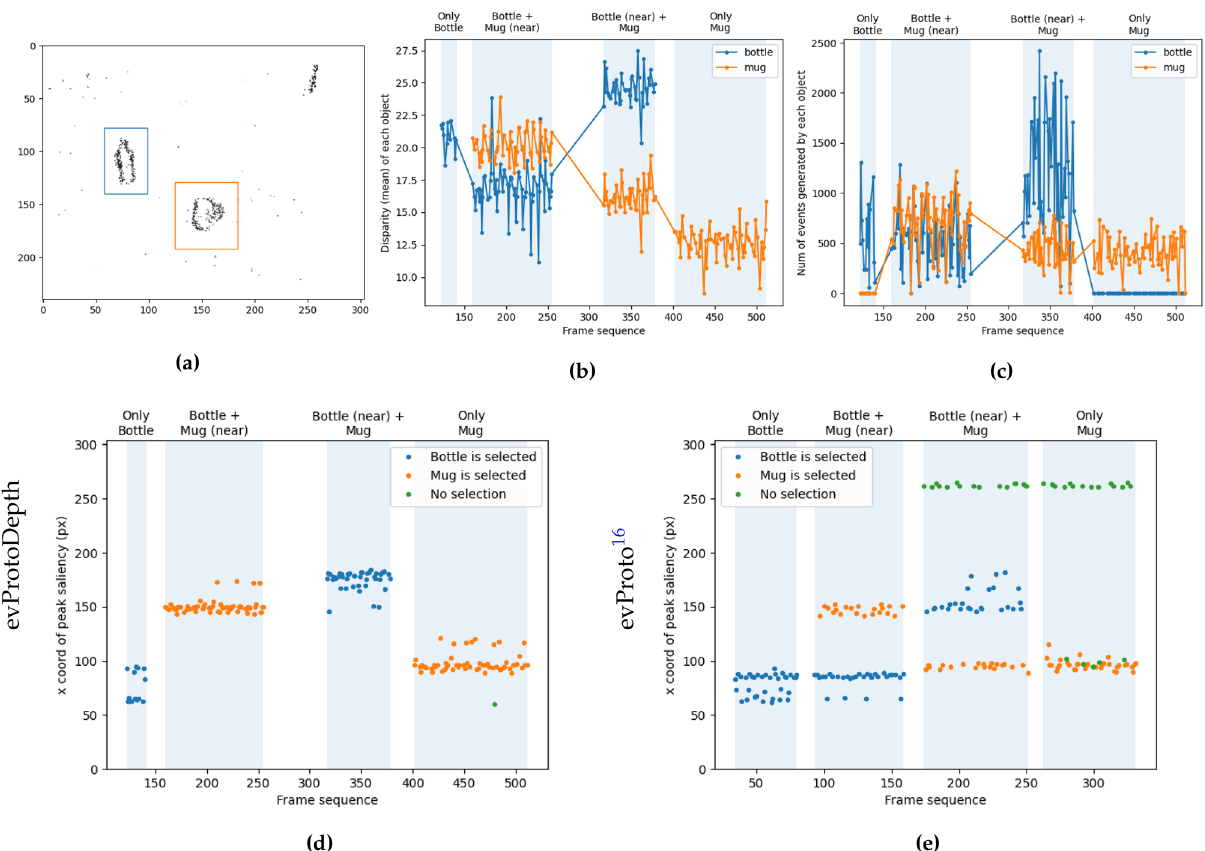
Figure 6. The disparity channel stabilises object selection in the bottle-mug dataset, during which the object positions are moved on a table. ( a ) Sample event frame with manually annotated object boundaries—at this particular time, the mug is closer to the camera. ( b ) Mean disparity within each object boundary in both object frames. ( c ) Number of events generated within each object boundary in both event frames. ( d , e ) x co-ordinates of the peak response in each frame for the evProtoDepth and evProto attention models. For each frame, an object is “selected” if the peak saliency pixel lies within its annotated boundaries, otherwise “No selection” occurs. There is only one unique object selection at each time stamp (frame). This means that for evProto in ( e ), the saliency peak jumps from one object to another frequently. Thus the orange, blue and green dots occur at (different) timestamps very close to each